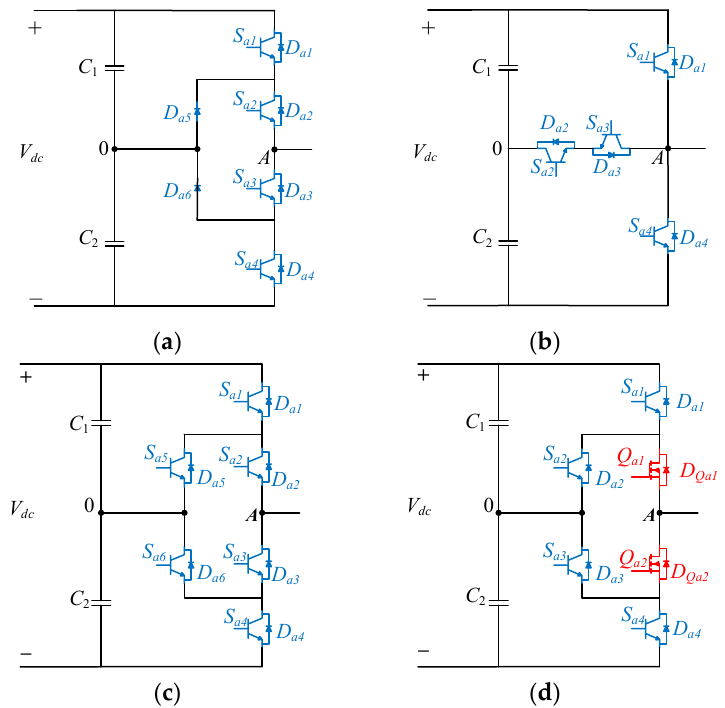
Figure 1. Basic circuit configuration of ( a ) NPC, ( b ) T-type, ( c ) ANPC, and ( d ) HANPC inverters.